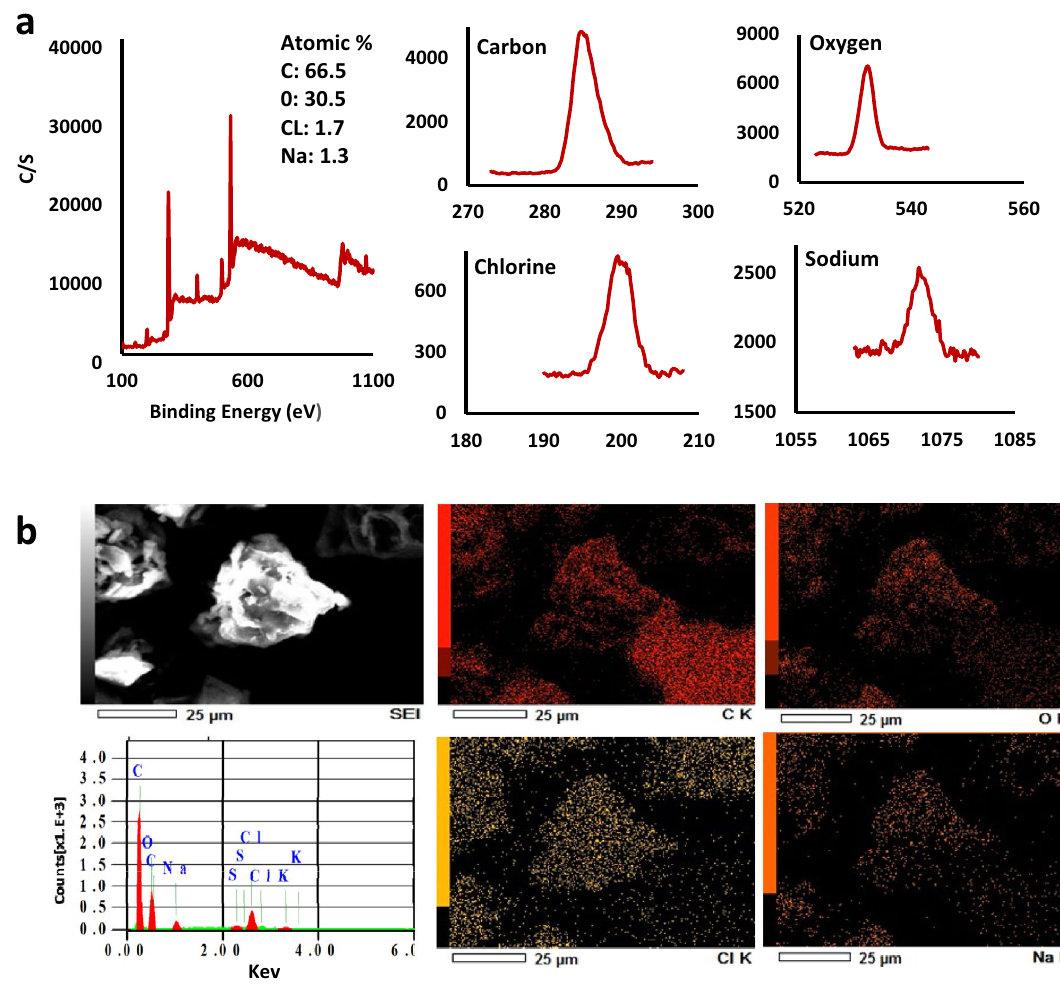
Figure 5. The elemental composition of date fruit melanin, ( a ) X-ray photoelectron spectroscopy (XPS), and ( b ) Energy dispersive spectroscopy (EDS), both showing carbon and oxygen as main components and small amounts of sodium and chlorine.